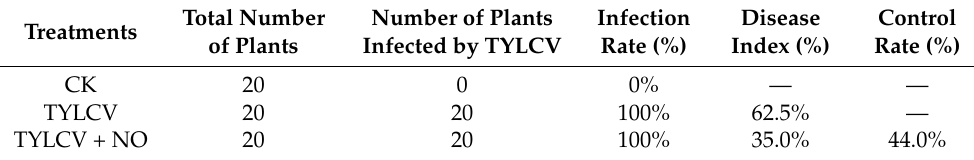
Table 2. Prevention and treatment effects of exogenous NO on TYLCV.